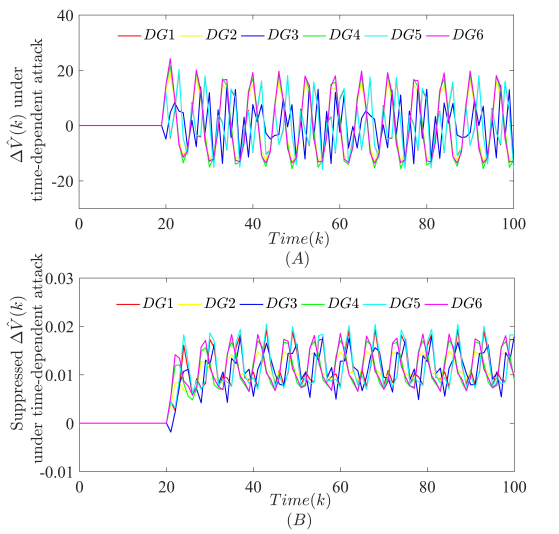
Figure 13. Estimation difference of the DGs using different resilient strategies under the time- dependent attack: ( A ) the strategy in [17]; ( B ) the proposed